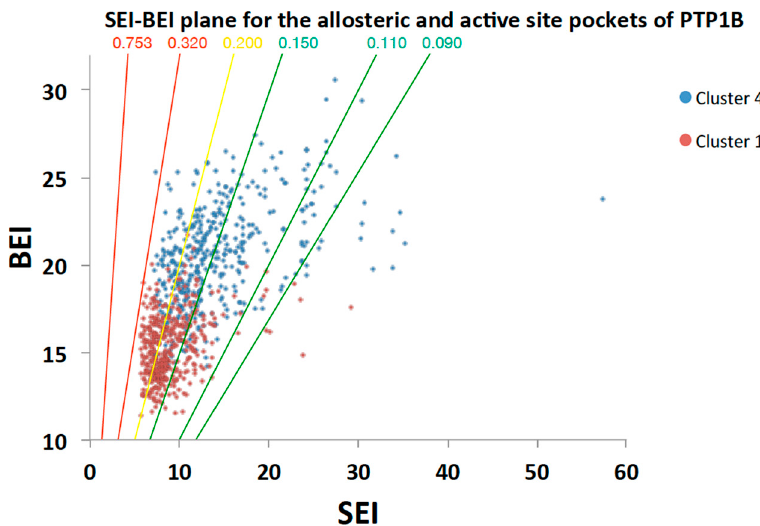
Figure 4. SEI-BEI plot for cluster 1 and 4. Selected ligands (top 500 ranked by ∆ G) from the targeted docking are shown. Red dots represent ligands from the active site cluster 1 and blue dots represent ligands from the allosteric site cluster 4. The PSA/MW ratios (0.753, 0.320, 0.200, 0.150, 0.110, 0.090) are plotted as lines and coloured according to drug-like chemical space with 0.753–0.320 being a poor region (red), 0.200 acceptable (yellow), and 0.150–0.090 a good drug like space (green). VSpipe also generates NSEI/nBEI plots (Figure 5), in which compounds are sorted according to their number of polar atoms, nitrogen and oxygen (NPOL). Each NPOL plane contains compounds with the same number of polar atoms (2, 3, 4, 5 . . . etc.). Polarity increases counter-clockwise by NPOL, whilst ligand efficiency increases along each NPOL plane